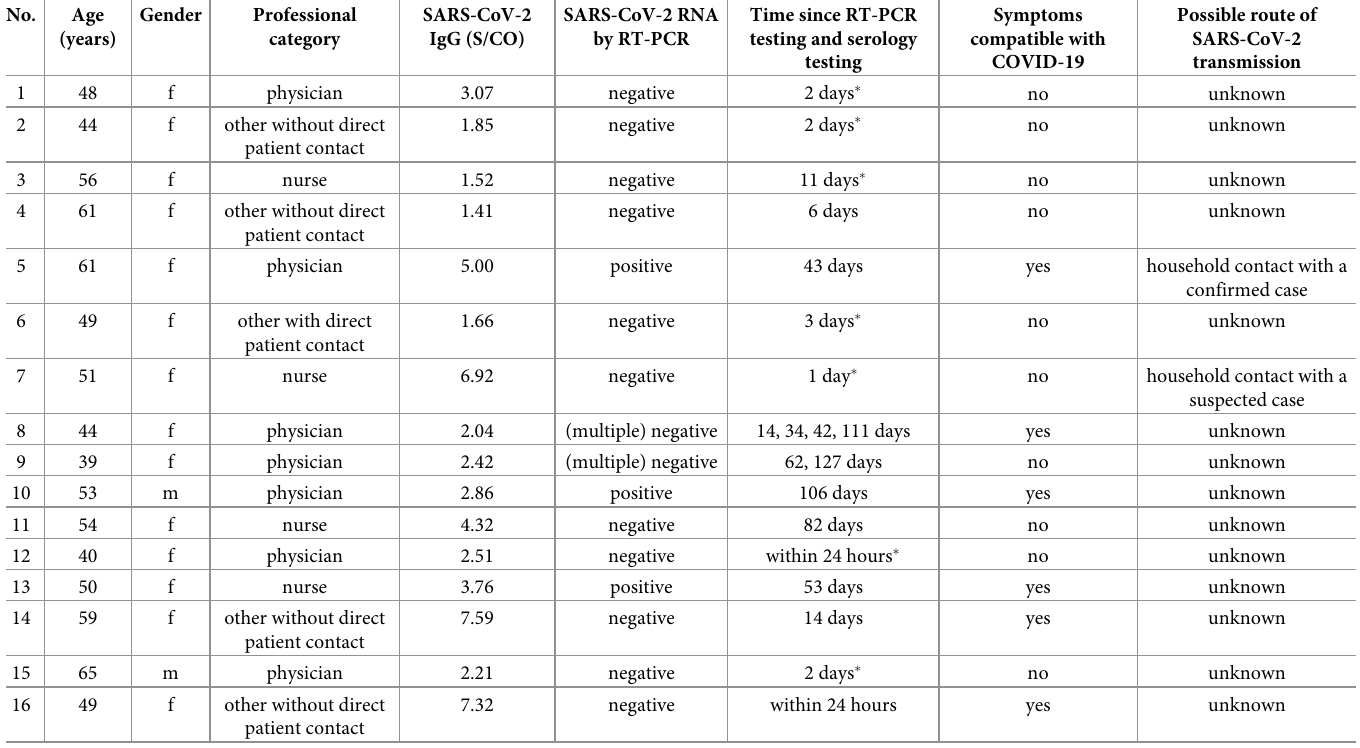
Table 2. Characteristics of the seropositive HCWs.